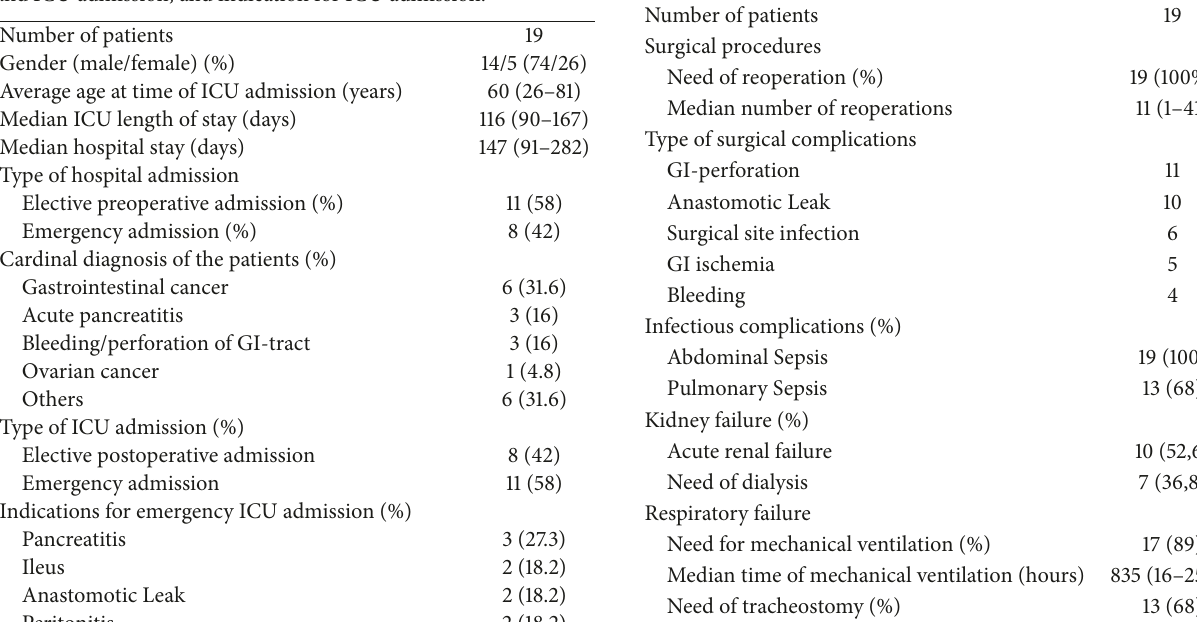
Table 2: Postoperative complications of surgical